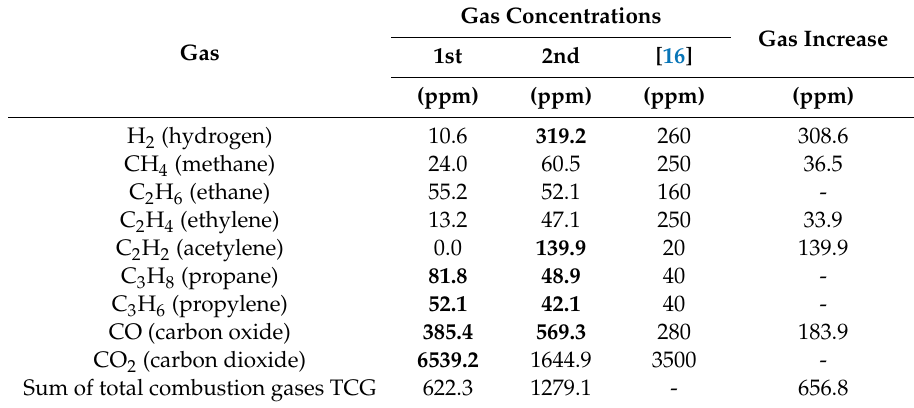
Table 5. Gas concentrations measured for the oil samples taken from 30 MVA, 110/10.5 kV power transformer (exceedance of the typical values is marked in bold font).